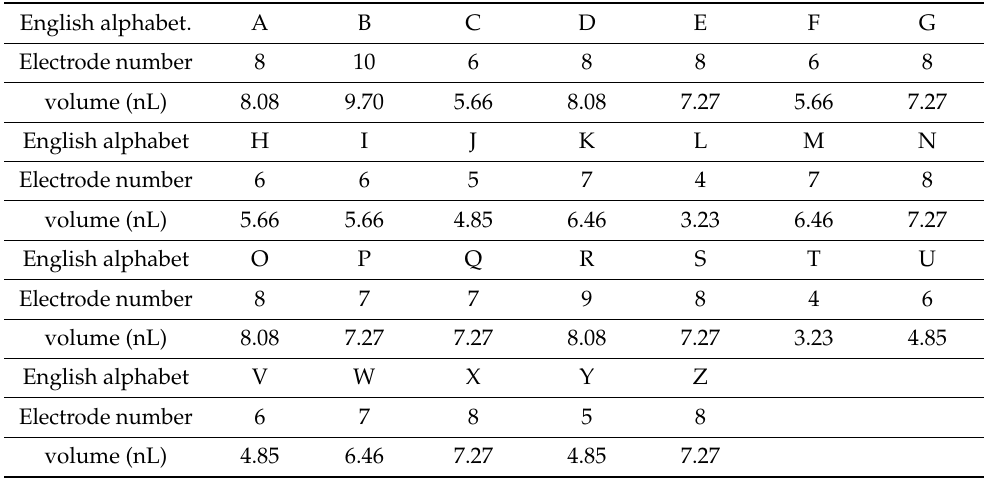
Table 2. Quantity of opening electrodes and droplet volume to pattern an English alphabet by using UV-SIL liquid. English